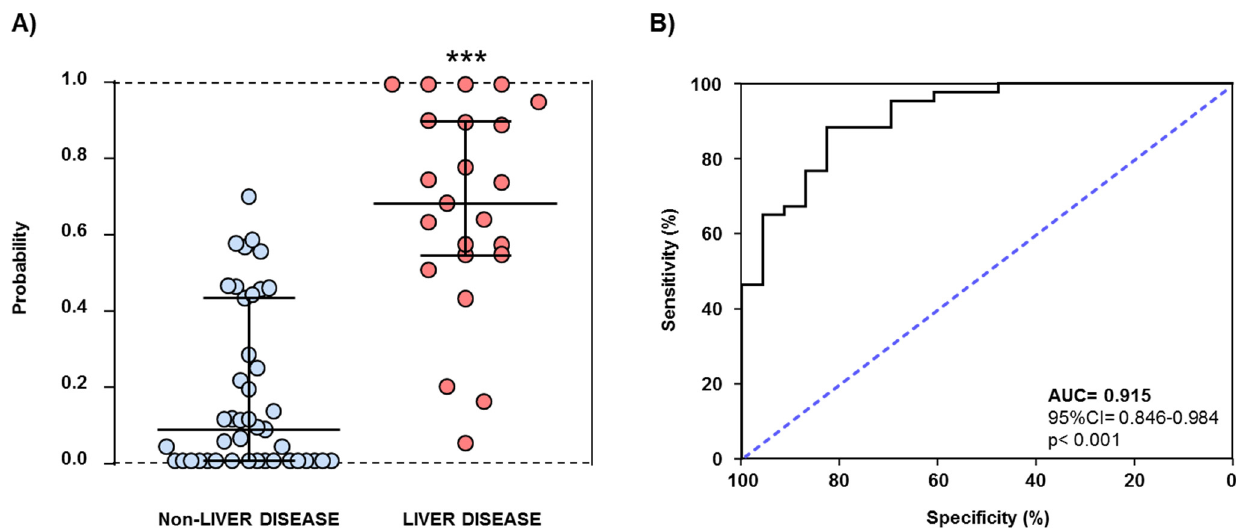
Figure 2. ROC analysis for a discriminative logistic model of patients with liver disease from patients without liver disease in the alcohol group. ( A ) Scatter plot of the predictive probabilities; and ( B ) ROC curve generated with probability values from a binary logistic model including LPA (log 10 -transformed), ATX (log 10 -transformed), problematic alcohol use, last period of alcohol abstinence (log 10 -transformed), and DSM criteria for AUD. Lines on the scatter plot are median and IQR. (***) p < 0.001 denotes significant differences using Mann–Whitney U test.